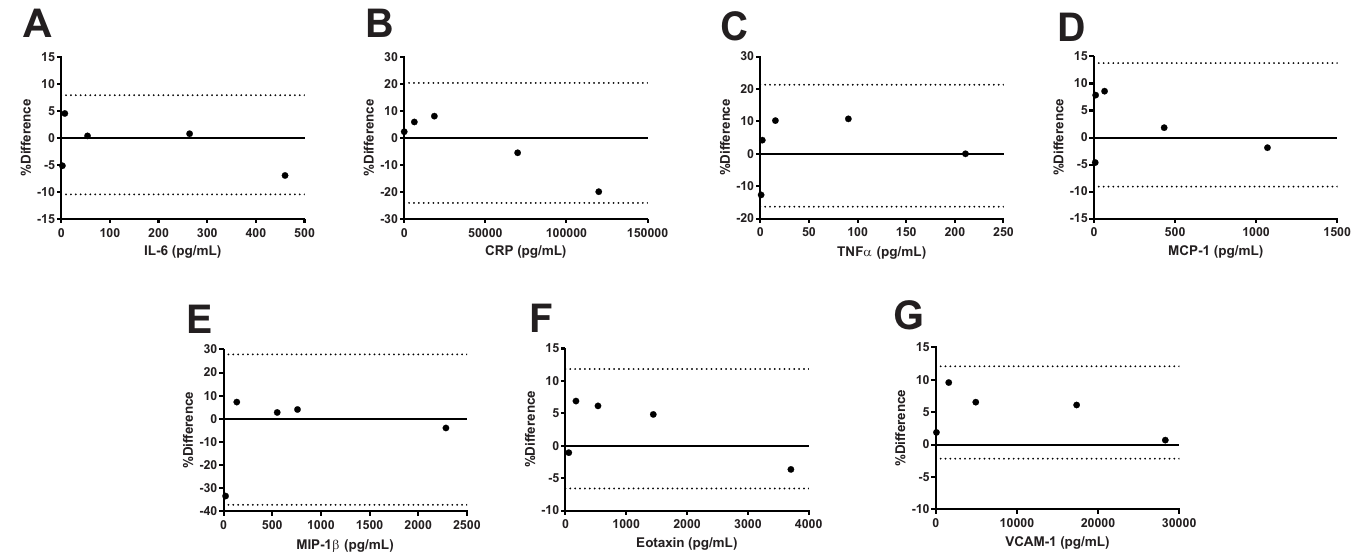
Fig 1. Assay validation Bland-Altman plots. (A) IL-6, (B) CRP, (C) TNF α , (D) MCP-1, (E) MIP-1 β , (F) Eotaxin, (G) VCAM-1. Dotted lined indicates 95% limits of agreement.